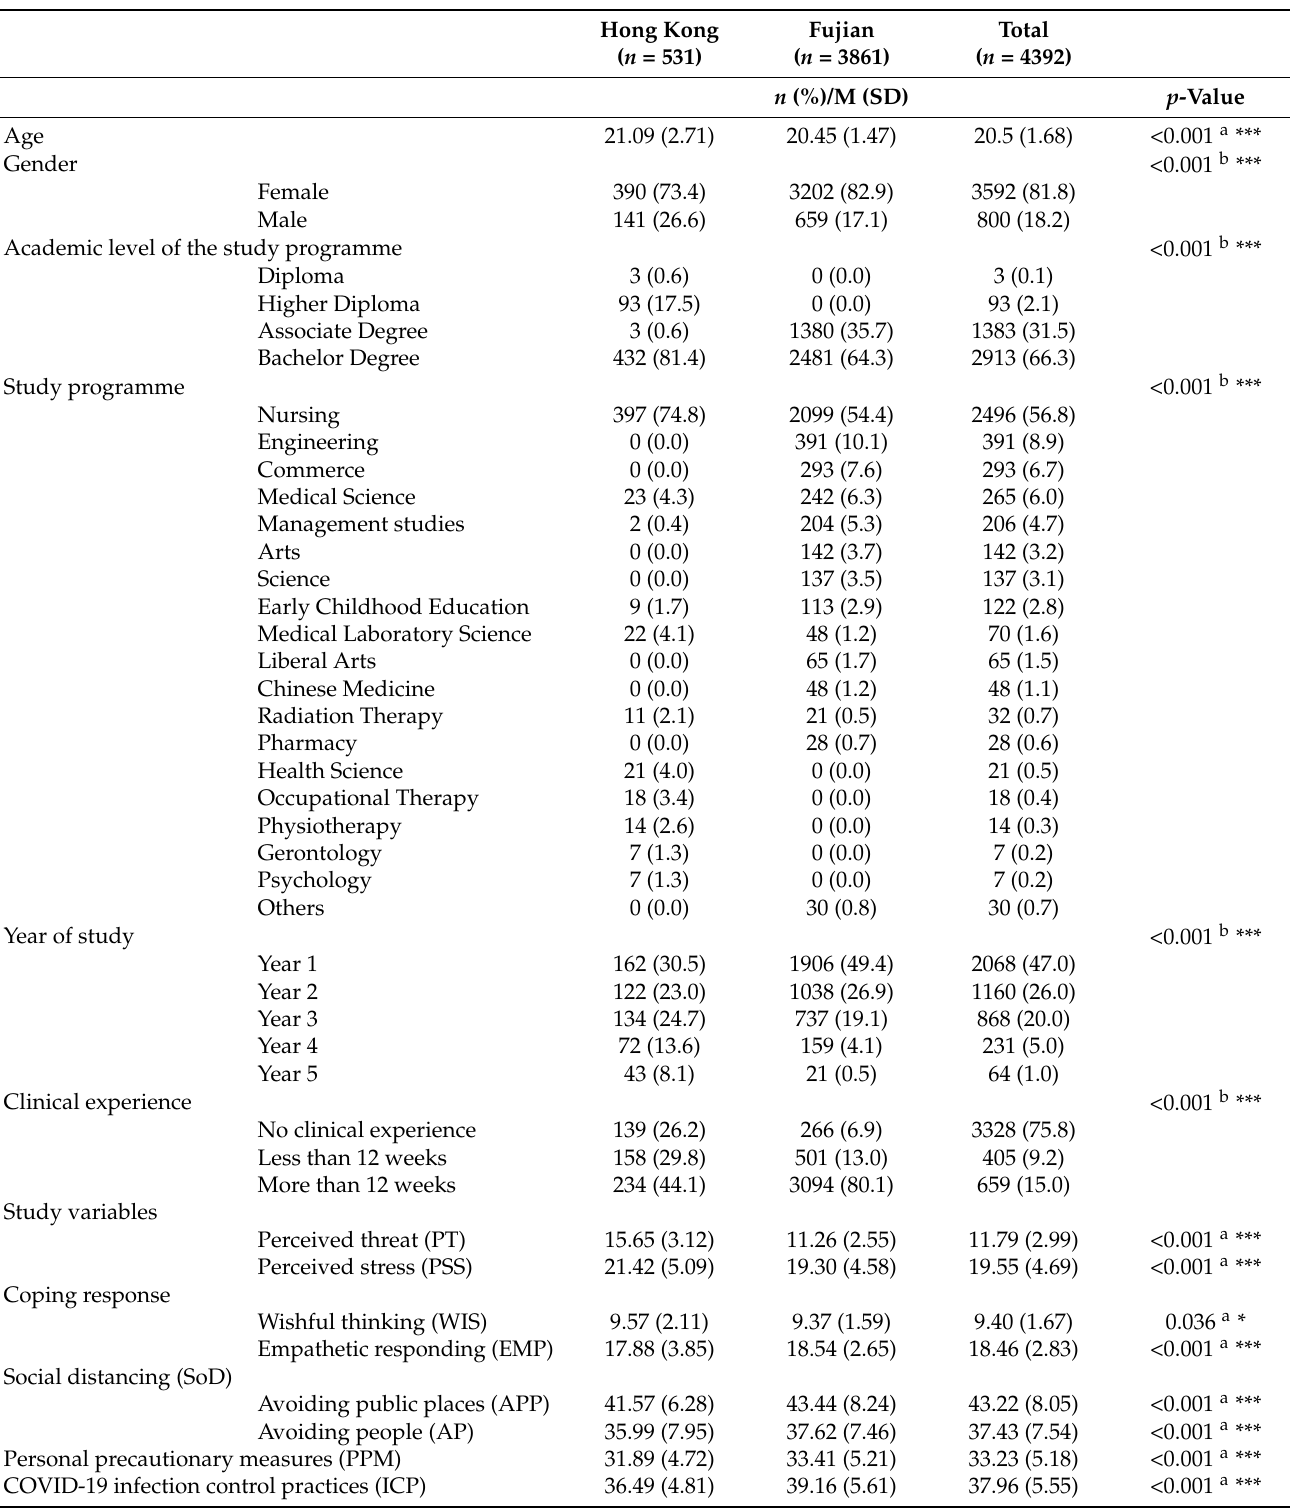
Table 1. Demographic characteristics of the participants and study variables by geographical